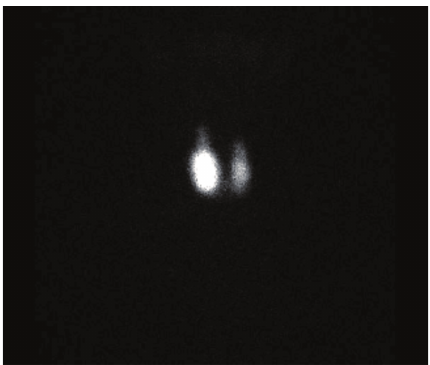
Figure 3: I 123 scintigraphy of the thyroid gland. There was a strong uptake corresponding to the tumor in the right lobe detected on the ultrasonography. A nonsuppressible uptake was also observed throughouttheremainingthyroidgland,thussuggestingunderlying Graves’disease.ThetotaluptakepercentageofI 123 forfourhourswas approximately 24% (range: